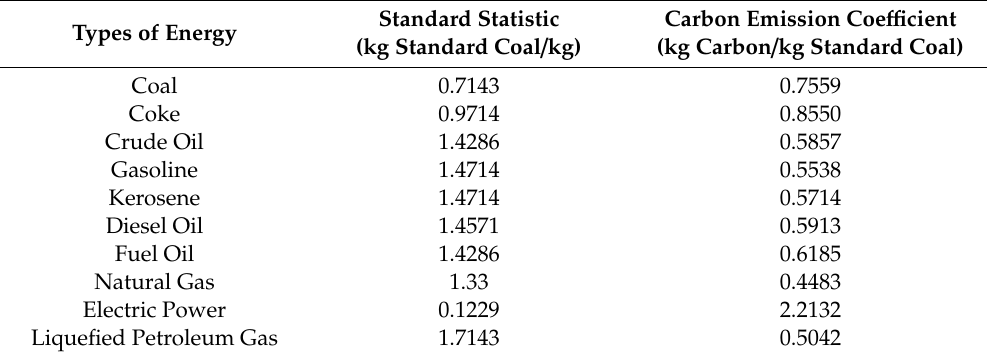
Table 3. Energy carbon emission